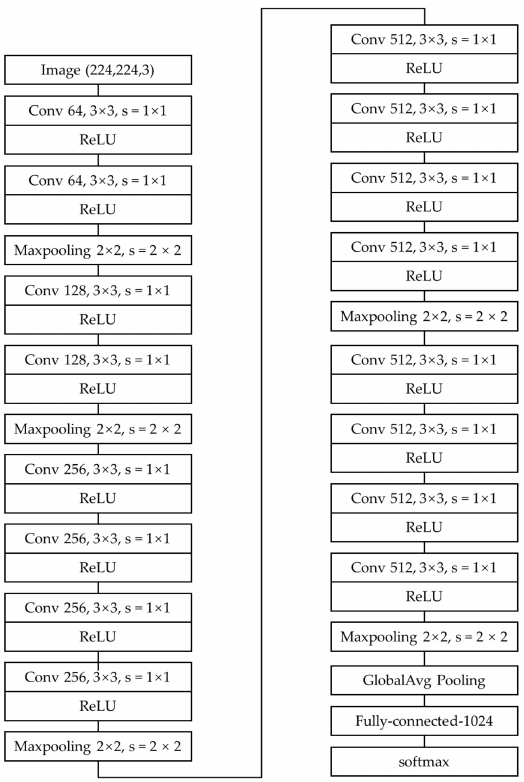
Figure 7. The VGG19